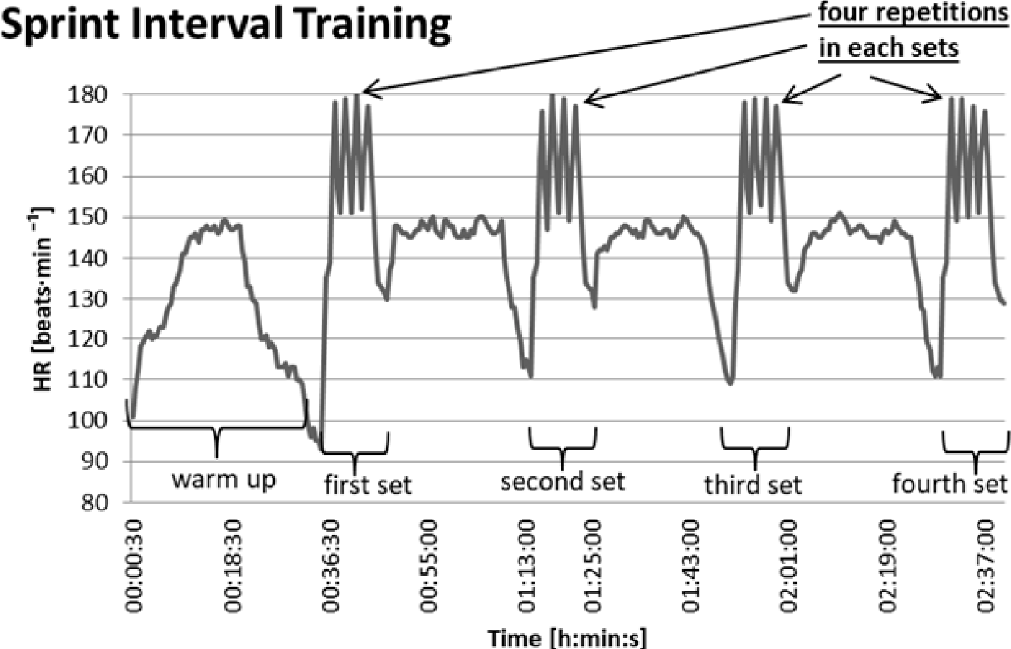
Figure 2. Diagram representing the sprint interval training with the heart rate (HR) of one of the participants.